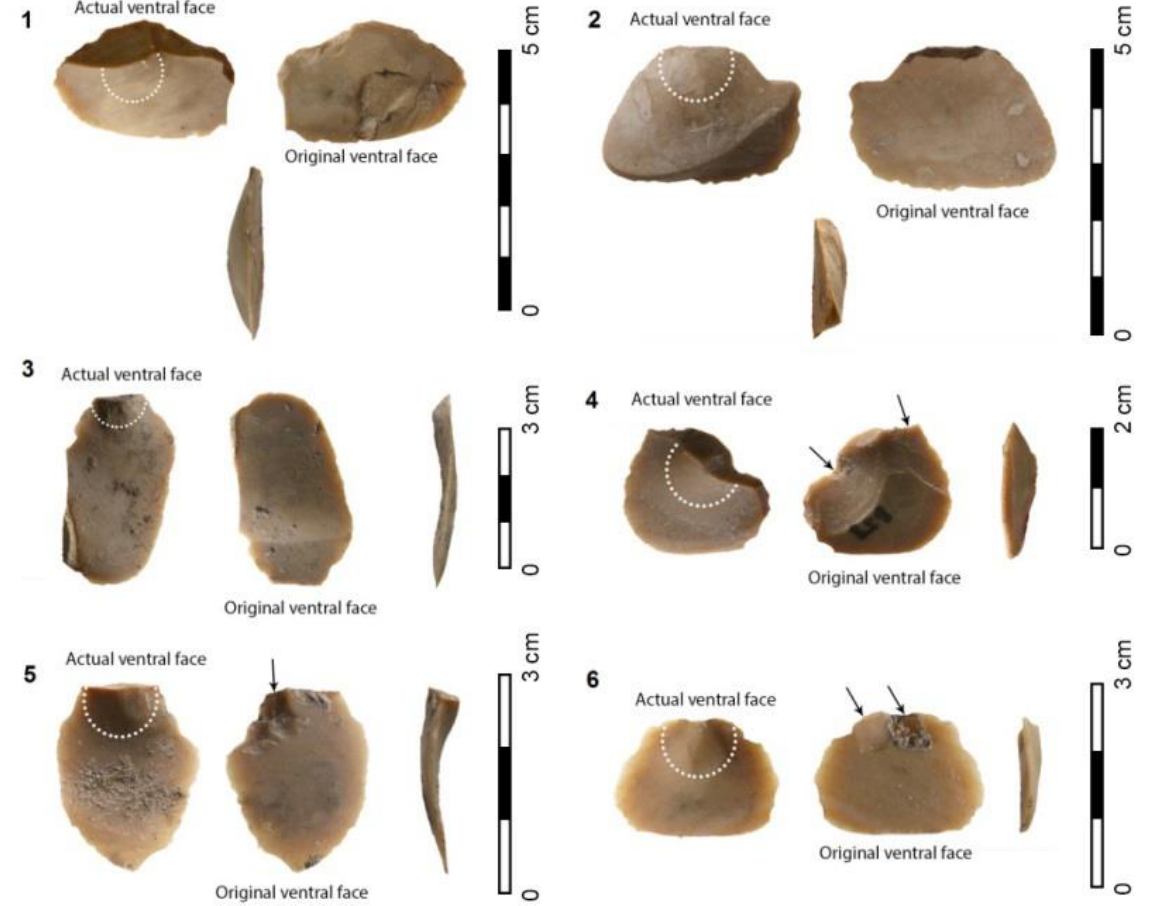
Figure 9. Regular items: 1-3 are regular items with plain dorsal face; 4-6 are regular items with previous removals. Dotted white line denotes the bulb of percussion while black arrows denote previous